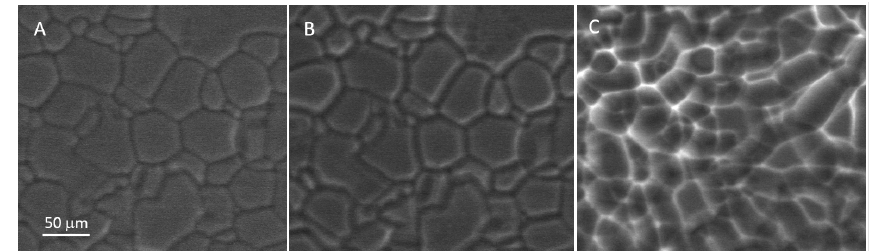
Figure 6. A thick polycrystalline ice film during sublimation. The grooves widen substantially. The last image appears to show contrast inversion of the grooves. ESEM imaging conditions: (a) P = 253 . 4Pa, T = − 10 . 2 ◦ C, P sat = 255 . 5Pa, h = 0 . 99; (b) P = 230 . 9Pa, T = − 10 . 1 ◦ C, P sat = 257 . 8Pa, h = 0 . 90; and (c) P = 232 . 8Pa, T = − 10 . 1 ◦ C, P sat = 257 . 8Pa, h = 0 . 90. All images have the same scale (see a